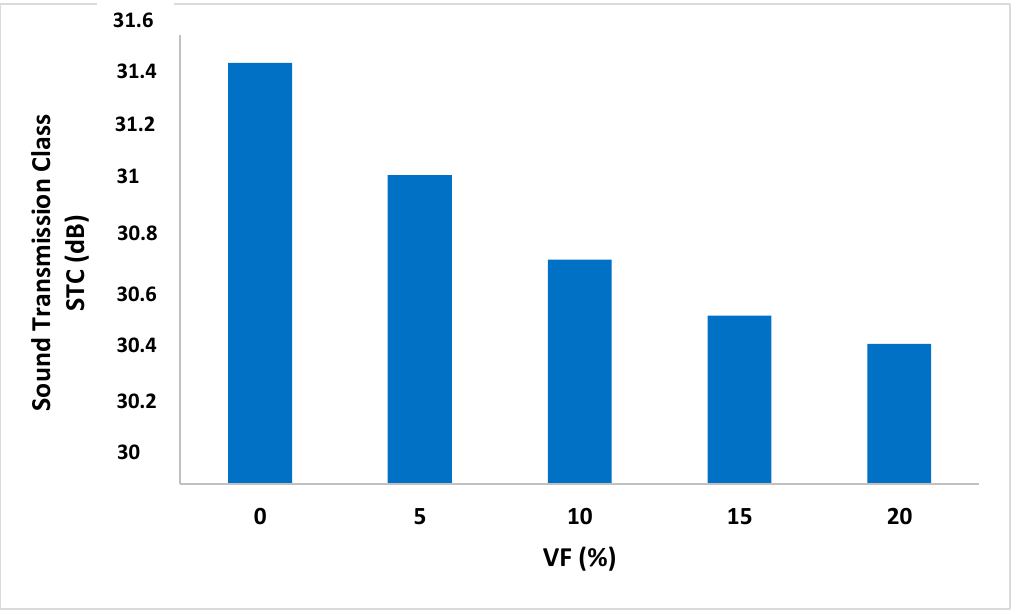
Figure 12. Effect of PO fibers on the sound transmission class of the mixtures.